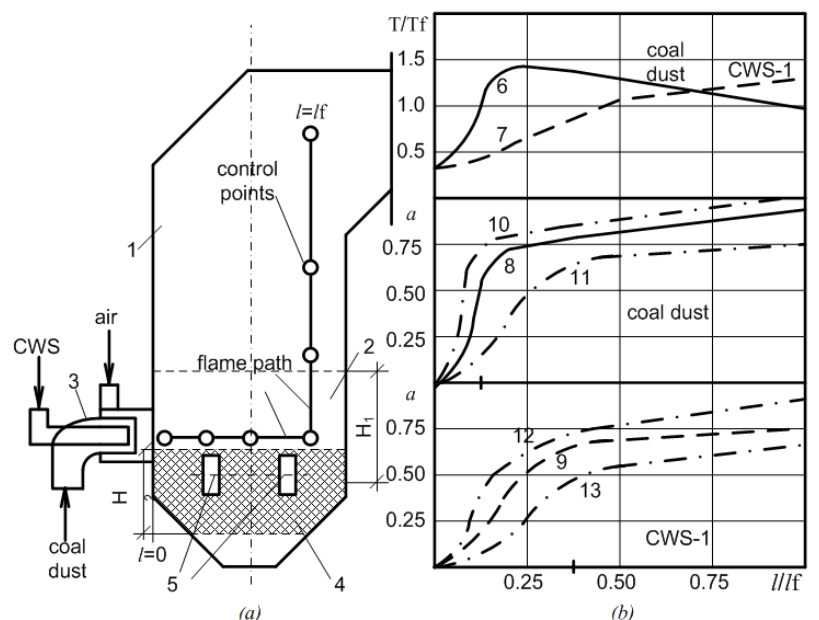
Figure 4. The nature of the change in dimensionless temperatures (T/Tf) and the degree of fuel burnout ( a ) in pulverized coal and suspension flares of Kavak brown coal on the TP-35 boiler: 1—furnace; 2—active combustion zone for dust and CWS in experiments; 3—burners for burning dust and CWS in experiments; 4, 5—calculated active combustion zone and burners for fine CWS; ( b ) 6, 7, 8, 9—integral curves; 10, 12—R < 90 microns; 11, 13—R > 90 microns; 6, 8—burning of dust with a maximum particle size of 350 microns; 7, 9—burning of CWS with a maximum particle size of 350 microns. (b)